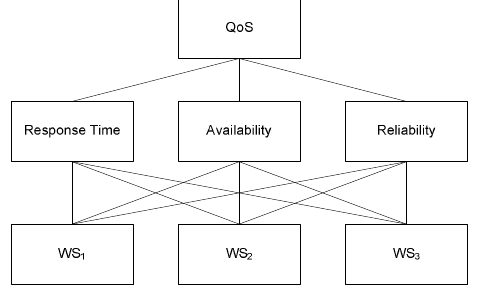
Fig. 1. Hierarchical model for web service selection when only the goal is a logical